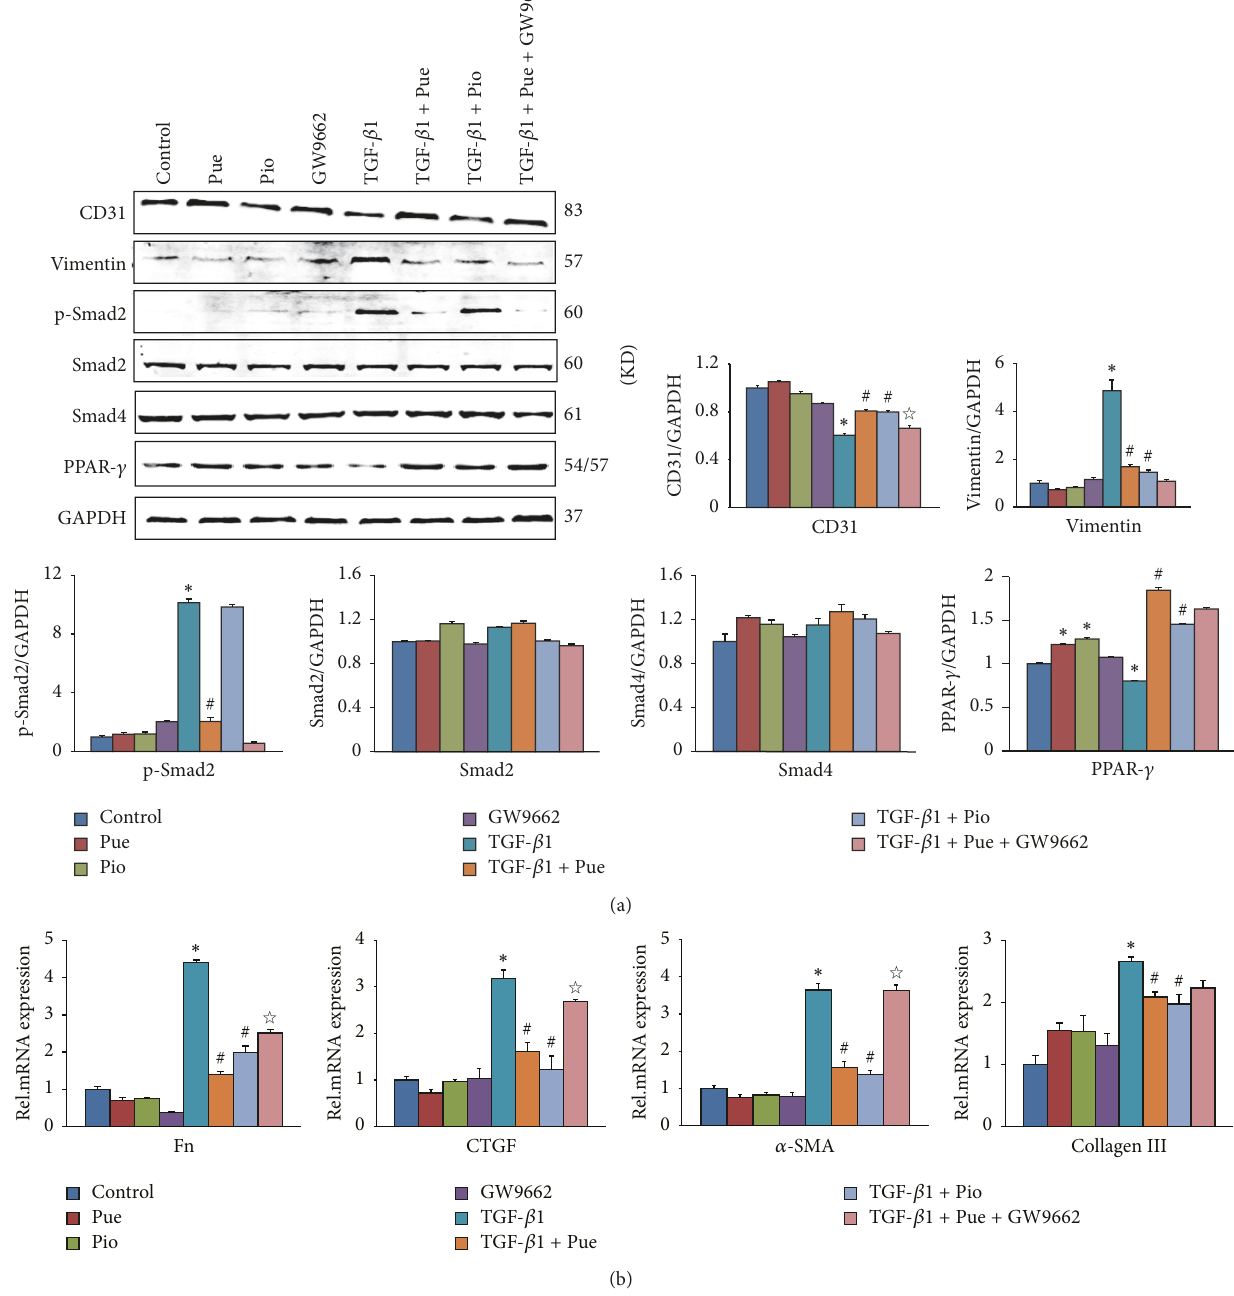
Figure 7: GW9662 counteracted puerarin’s suppression effect on EndMT. (a) HUVECs were preincubated with puerarin (50 𝜇 M) or pioglitazone (20 𝜇 M) in the presence or absence of GW9662 (10 𝜇 M) for 30 min and then treated with TGF- 𝛽 1 (10ng/ml) for 48 h. The protein levels of CD31, vimentin, p-Smad2, Smad2, Smad4, and PPAR- 𝛾 in cell lysates of indicated groups were detected by WB, normalized to GAPDH (𝑛 = 6) . ∗ 𝑝 < 0.05 versus control group; # 𝑝 < 0.05 versus TGF- 𝛽 1 group; f 𝑝 < 0.05 versus TGF- 𝛽 1 + Pue group. (b) HUVECs were treated in the same way as mentioned above. mRNA levels of CD31, vimentin, Fn, CTGF, 𝛼 -SMA, and collagen III in indicated groups were tested by RT-PCR, normalized to GAPDH (𝑛 = 6) . ∗ 𝑝 < 0.05 versus control group; # 𝑝 < 0.05 versus TGF- 𝛽 1 group; f 𝑝 < 0.05 versus TGF- 𝛽 1 + Pue